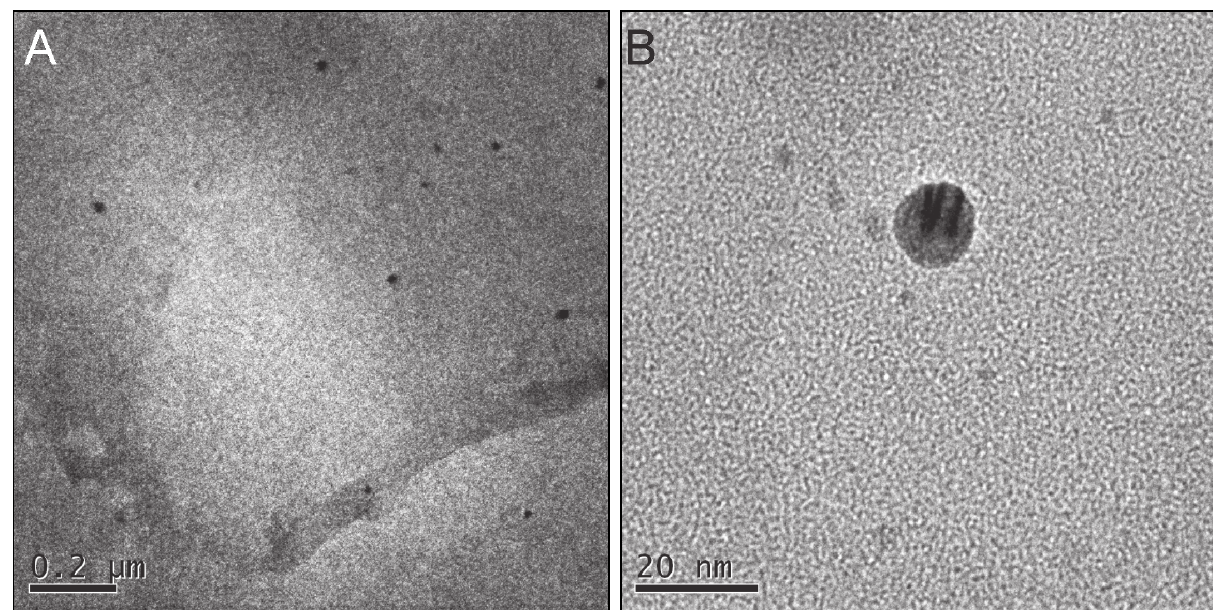
Figure 2. Distribution of nanoparticles in the adhesive. (A) Representative image at low magnification, scale bar 0.2 μm. (B) Representative image at higher magnification, scale bar 20 nm. Table III. Frequency of ARI scores for adhesive control and adhesive/ Cu NPs. ARI Control Adhesive with Cu NPs